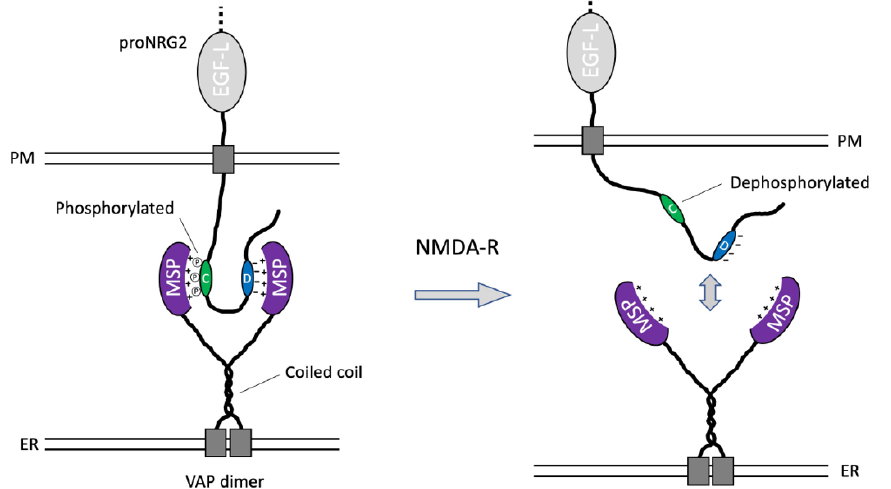
Figure 6. Working model of proNRG2/VAP interactions. The schematic depicts a single proNRG2 molecule cooperatively engaging with a VAP dimer via its two noncanonical, low-affinity FFAT motifs located in the C- and D-boxes. Interactions between the VAP MSP domain and the cryptic FFAT site in the C-box require phosphorylation of Ser/Thr residues. Conversely, their dephosphorylation downstream of NMDA receptor activation promotes the dissociation of proNRG2 from VAP. See Discussion for further details.